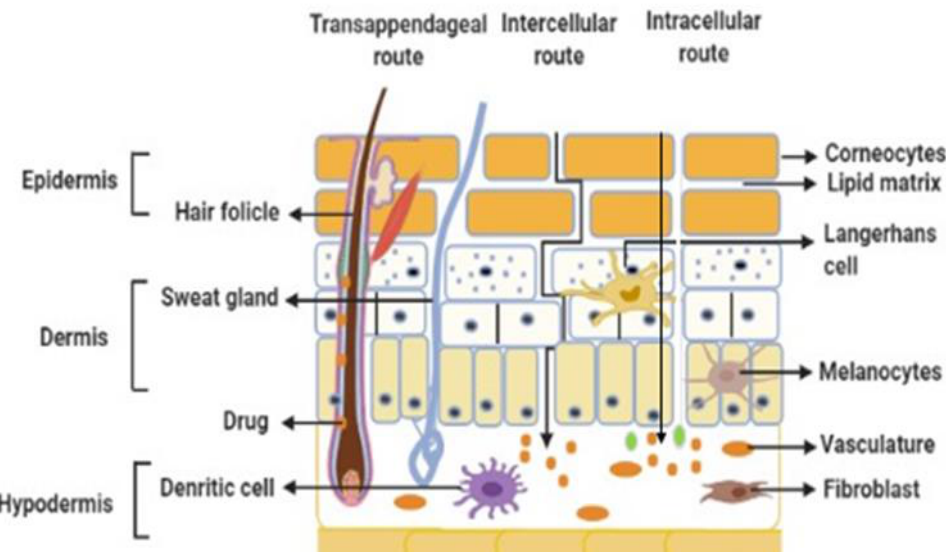
Figure 3. Schematic representation of the permeation process through the skin.